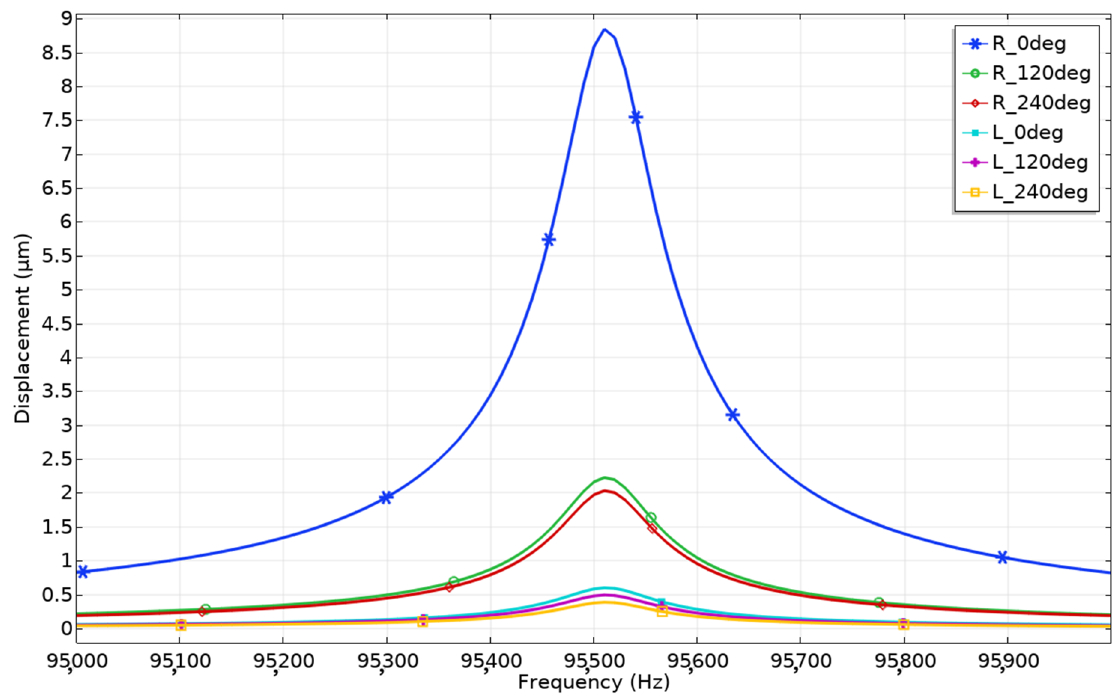
Figure 9. Amplitude—frequency characteristics of the robot when segment R 0deg is excited.